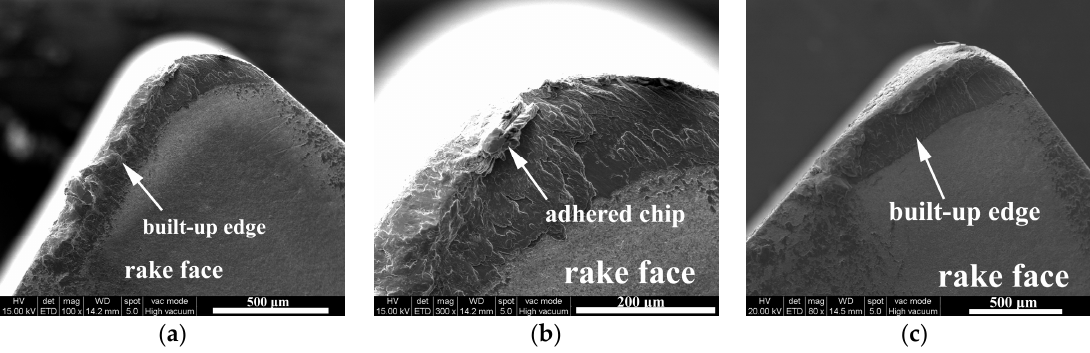
Figure 12. SEM images of rake face of the uncoated insert (K20): ( a ) cutting speed of 50 m/min, cutting time of 3 min; ( b ) magnification of tool nose in Figure 12a; and ( c ) cutting speed of 60 m/min, cutting time of 6 min; (feed rate of 0.1 mm/r and depth of cut of 1.0 mm for ( a – c )).